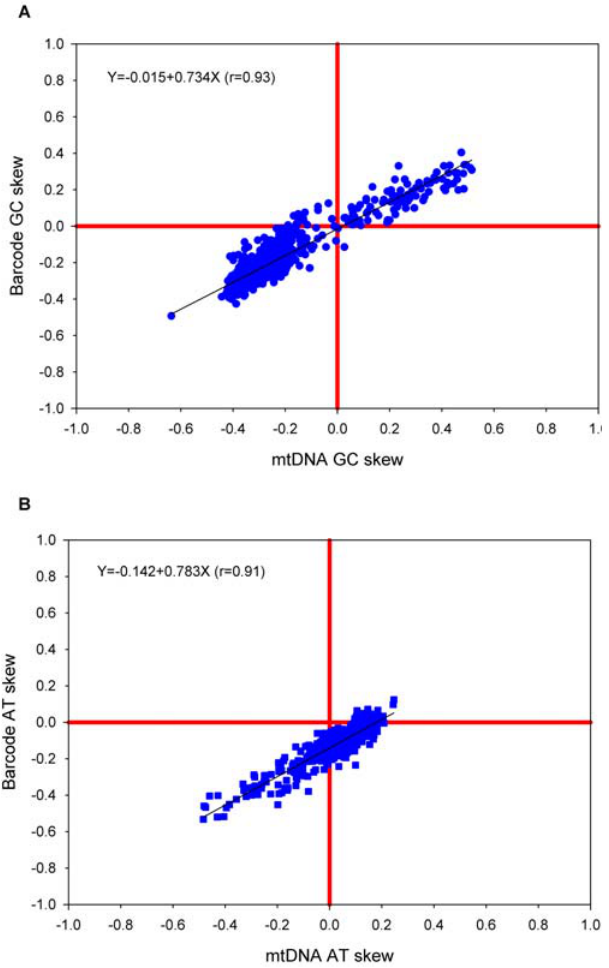
Figure 4. Correlations between nucleotide skews in the entire mitochondrial genome and in the DNA barcode sequences. Panel A shows the results for GC skew [(G-C)/(G + C)]. Panel B shows the results for AT skew [(A-T)/(A + T)].